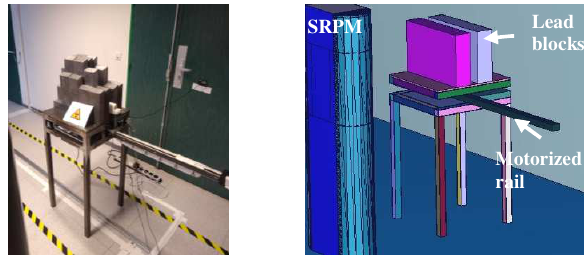
Fig. 4 Static platform (on the left : experimental setup, on the right model).